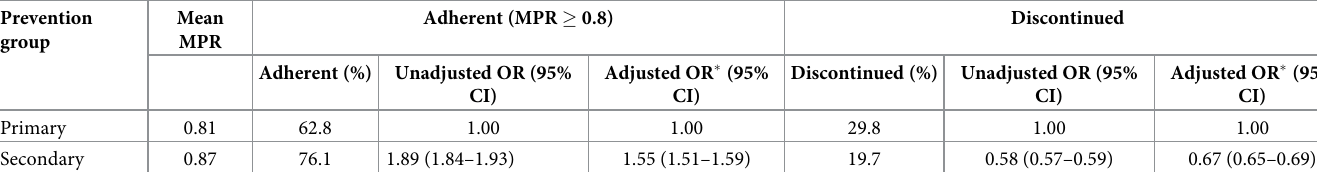
Table 2. Mean MPR, adherence, and discontinuation in primary and secondary prevention groups in first year of